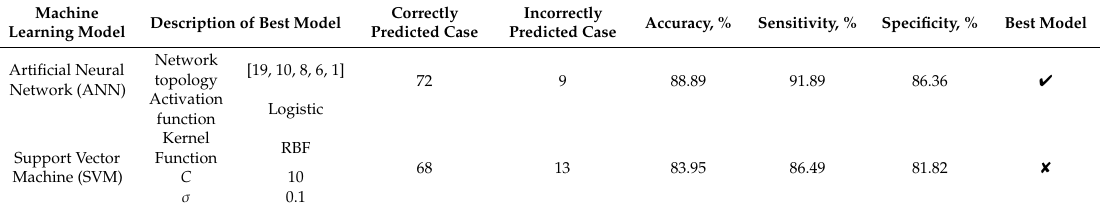
Table 19. Comparison between the best models from the ANN and